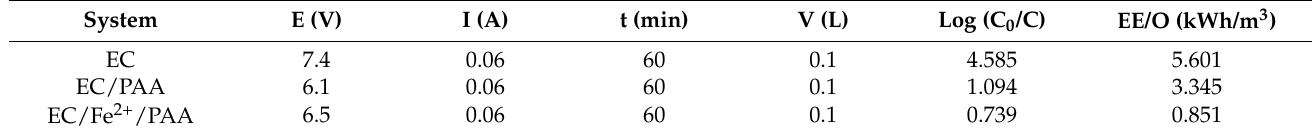
Table 1. Electrical energy consumption for different systems.